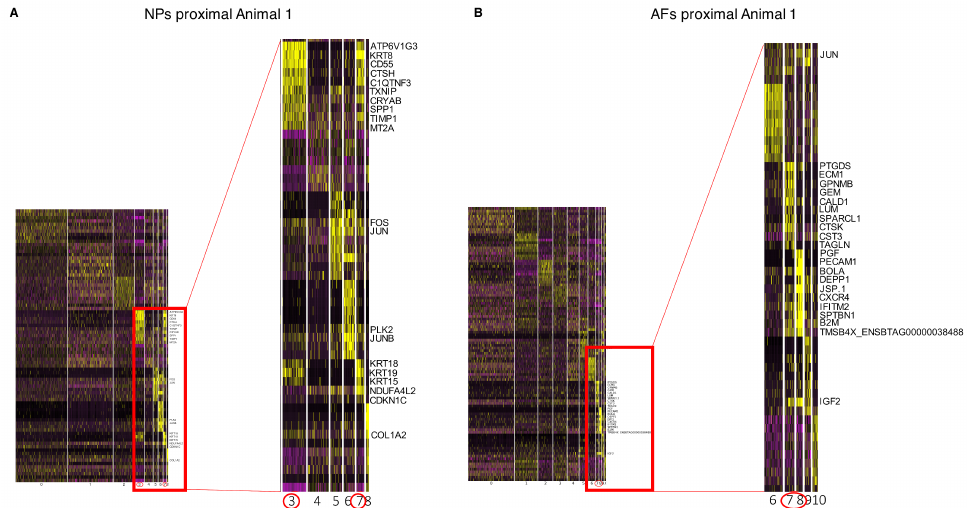
Figure 9. Genes that are highly expressed in scRNAseq clusters. Genes that are highly expressed in the clusters of interest in the scRNAseq data. ( A ) From the NPs proximal Animal 1, the Clusters 3 and 7 previously identified were selected. ( B ) From the AFs proximal Animal 1, the Clusters 7 and 8 previously identified were selected. The focus was pointed on the genes that are highly expressed in the clusters of interest. Higher expression value are highlighted in